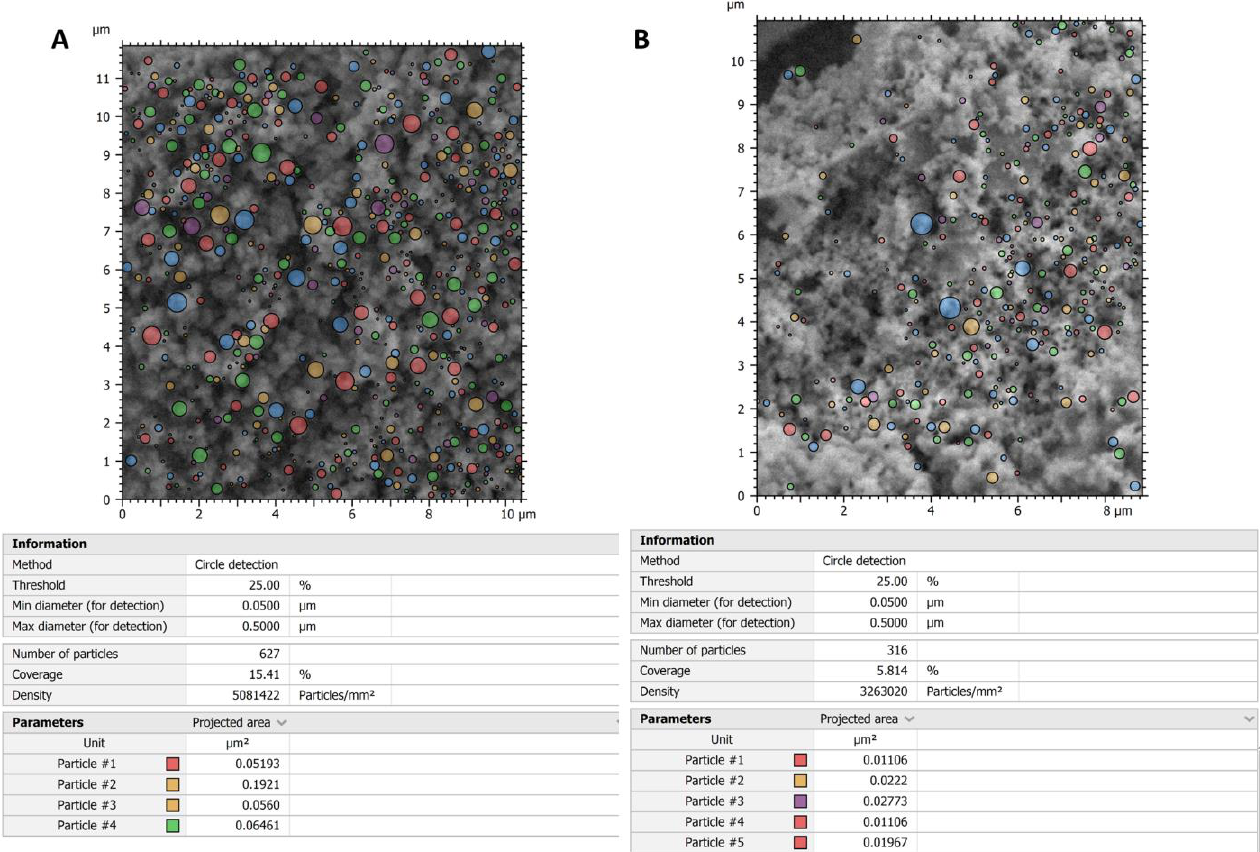
Figure 7. Analysis of globular structures in control ( A ) vs. treated samples ( B ). The particle analysis tool of Hitachi 3D map software revealed that the globular structures in the control sample are about twice those of the treated sample. This may be explained by thinking of a disassembling effect of the treatment on the filament that forms the ECM trabeculae.